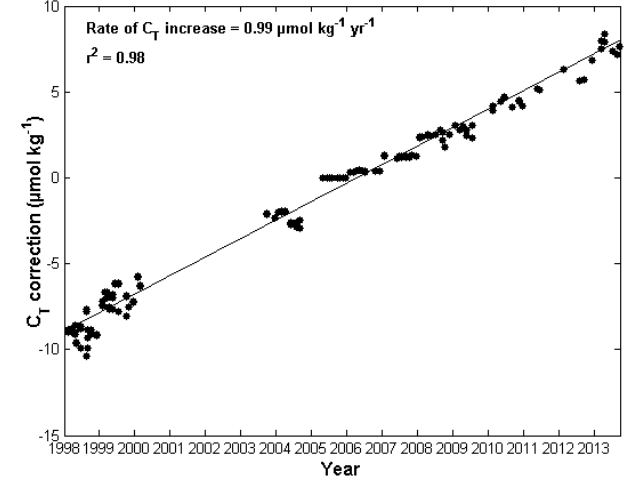
Figure 3. Rate of increase applied to correct the C T measurements in reference to the year 2005.